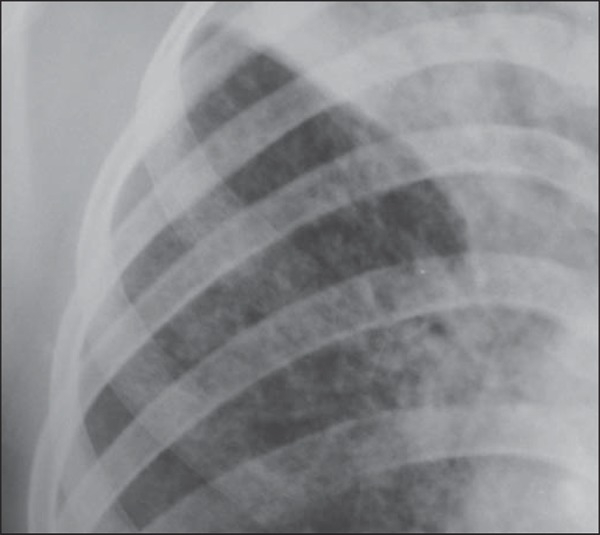
Chest radiography of a 14-year-old young girl showing the presence of pulmonary
micronodules.